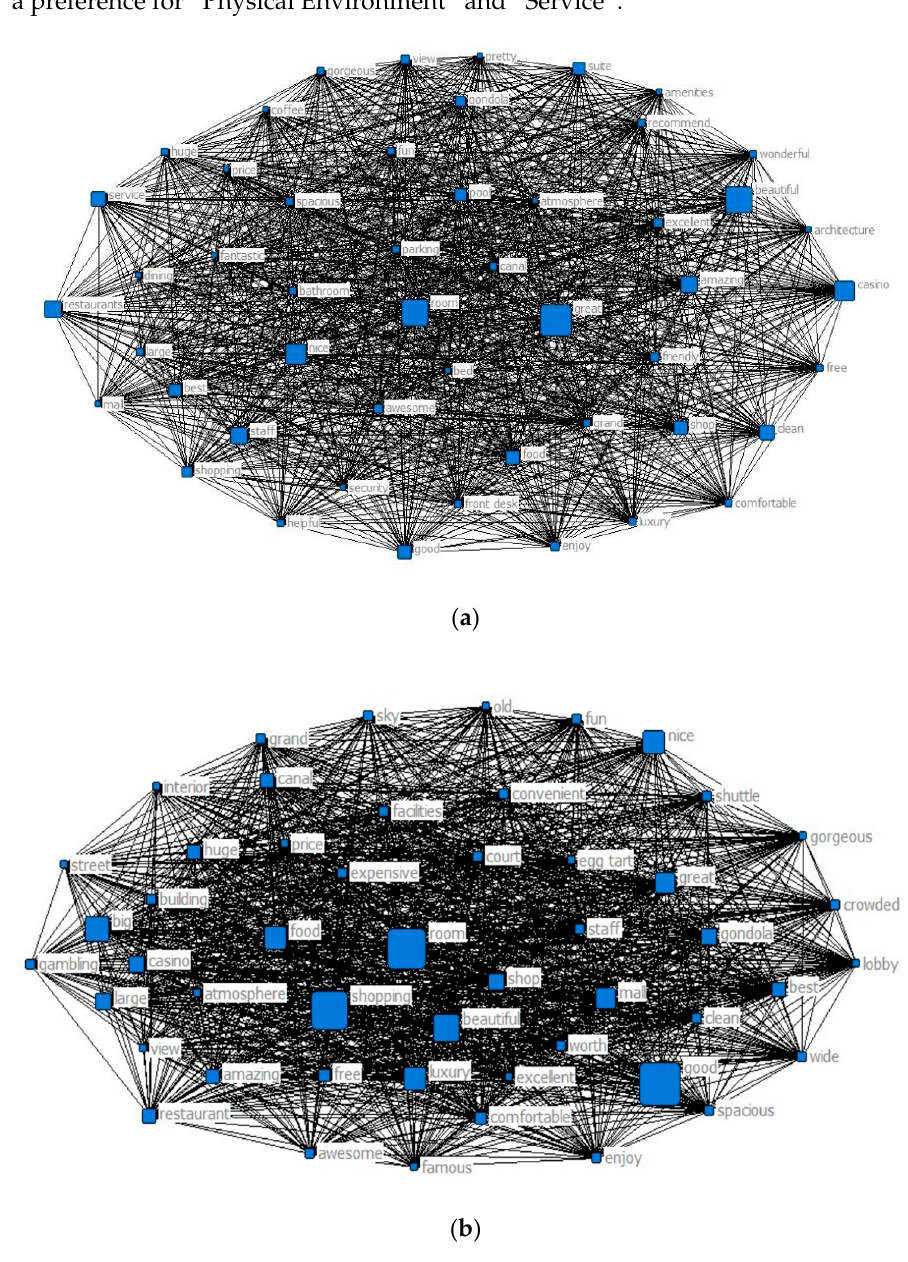
Figure 2. Keyword visualization of network analysis. ( a ) The Venetian in Las Vegas; ( b ) The Venetian in Macao.